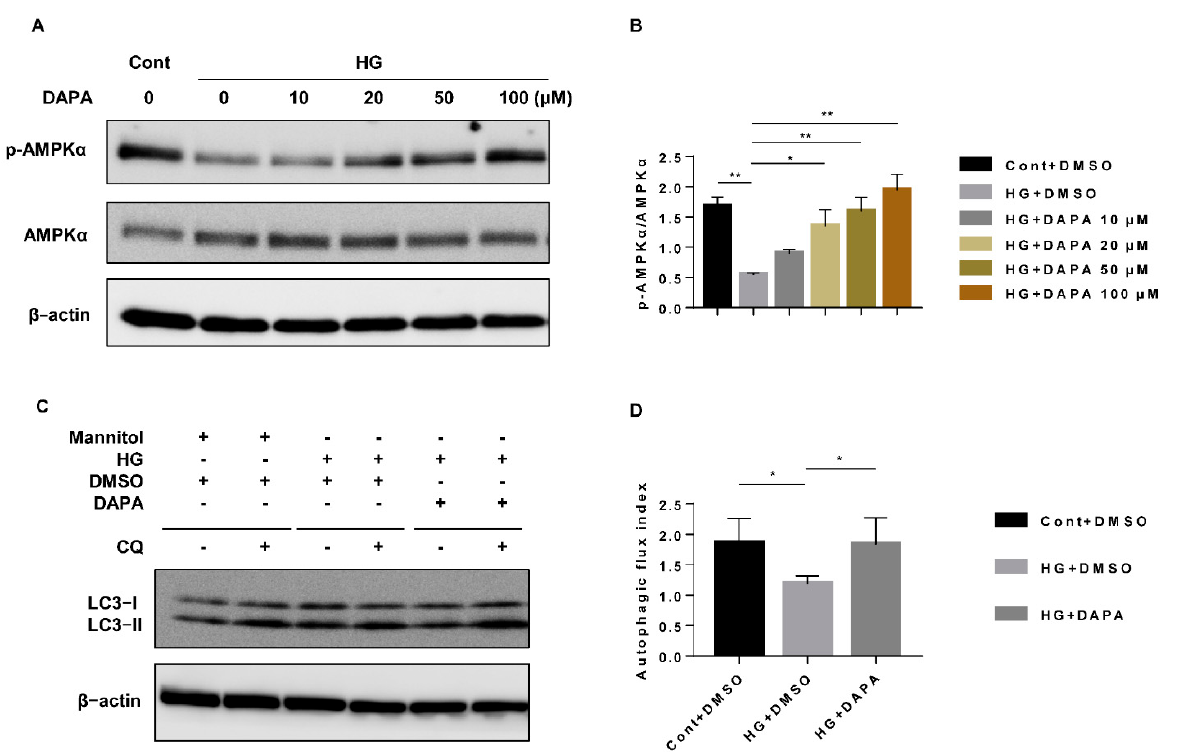
Figure 2. Dapagliflozin increased the activity of AMPK and suppressed the reduction in autophagic flux due to HG. ( A ) HK-2 cells were treated with dapagliflozin (0–100 µ M, for 48 h) under HG conditions, and p-AMPK was assessed by western blotting. ( B ) Densitometric evaluation of ( A ) (n = 3). ( C ) HK-2 cells were treated with Cont, HG (30 mM), HG (30 mM) with dapagliflozin (20 µ M) for 48 h, and chloroquine (50 µ M) or vehicle for 1 h. Autophagic flux was determined with the LC3-II ratio in the presence and absence of chloroquine. ( D ) Densitometric evaluation of ( C ) (n = 5). All data represent the means ± standard deviation (SD). * p < 0.05 vs. the indicated group, ** p < 0.01 vs. the indicated group. Cont, control; HG, high glucose; DAPA, dapagliflozin; and CQ, chloroquine.